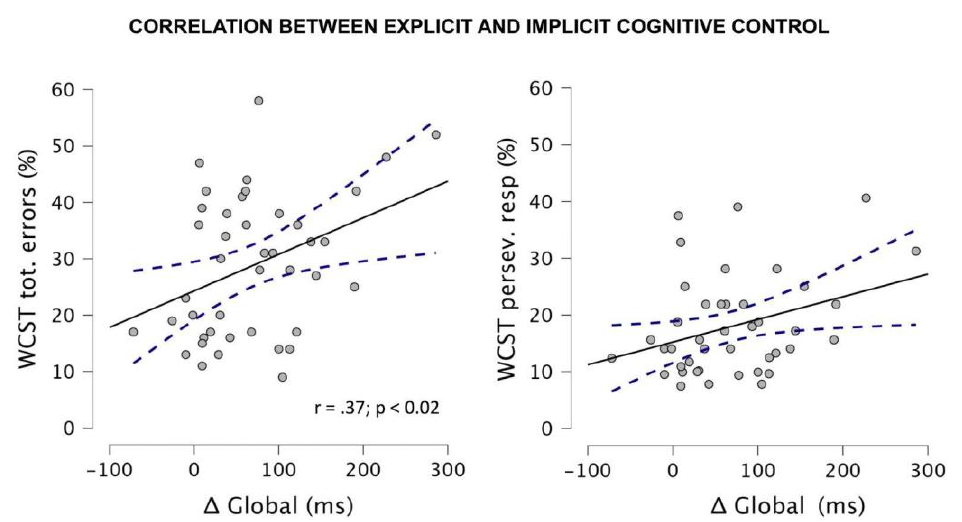
Figure 3. Correlational results. Correlation between ∆ Global single-subject values at the DTP task and the percentage of total errors (left panel) and perseverative errors (right panel) at the WCST task.